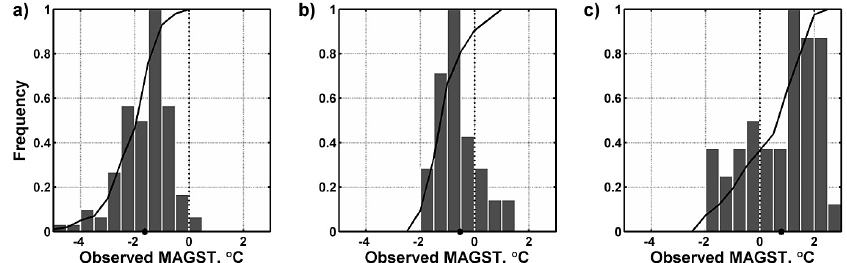
Figure 2. Histograms of measured mean annual ground surface temperatures (MAGSTs) at the logger sites in (a) Ny-Ålesund, (b) Juvvasshøe and (c) Finse. The cumulative curve is given as a solid black line, and average MAGST is marked with a black dot on the x axis. The fraction of samples below 0 ◦ C is given by the intersection of the cumulative curve and the 0 ◦ C line (stippled line).